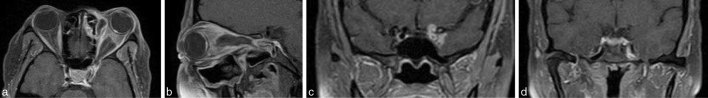
Post-contrast T
1 weighted fat-saturated axial, sagittal and coronal images demonstrate three peripherally enhancing lesions in the left orbit. A 15 × 8 × 10 mm lesion is seen in the extraconal space on the medial aspect of the orbit subperiosteally, displacing the medial rectus laterally with subtle enhancement in the left ethmoid sinus (a). A 33 × 18 × 15 mm intraconal retro-orbital lesion communicates with the lesion along the medial wall and extends to the orbital apex and left cavernous sinus, with the intracranial component measuring 7 mm (a, c). The left optic nerve is encased by the intraconal lesion with enhancement in the distal part of the optic nerve close to insertion at the globe (a, b). The enhancement is seen to extend along the left internal carotid artery, which has a small calibre with thickened wall (a–d). There is also an inferior extension into the left pterygopalatine fossa. The third lesion is seen in the lower preseptal space measuring 23 × 7× 9 mm, and shows signal intensity similar to fluid with peripheral enhancement (b).